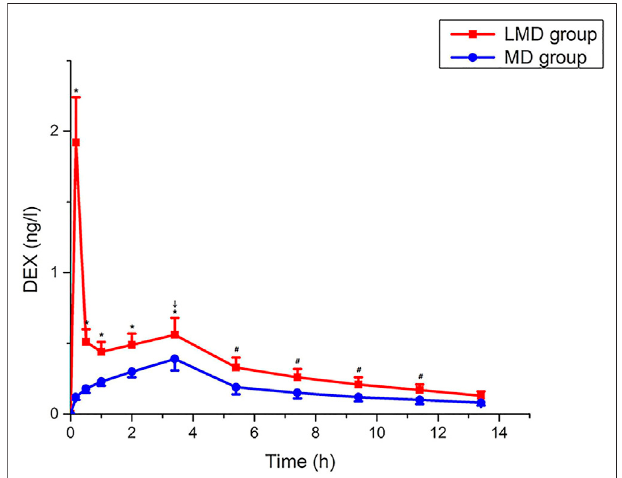
FIGURE2| Theproportionof fl atuspatientsateachtimepoint(lessthan or equal to 1 day, denoted as 0 – 1; greater than 1, less than or equal to 2 denoted as 1 – 2; greater than 2, less than or equal to 3 denoted as 2 – 3). Compared with the MD group, the LMD group had more patients with